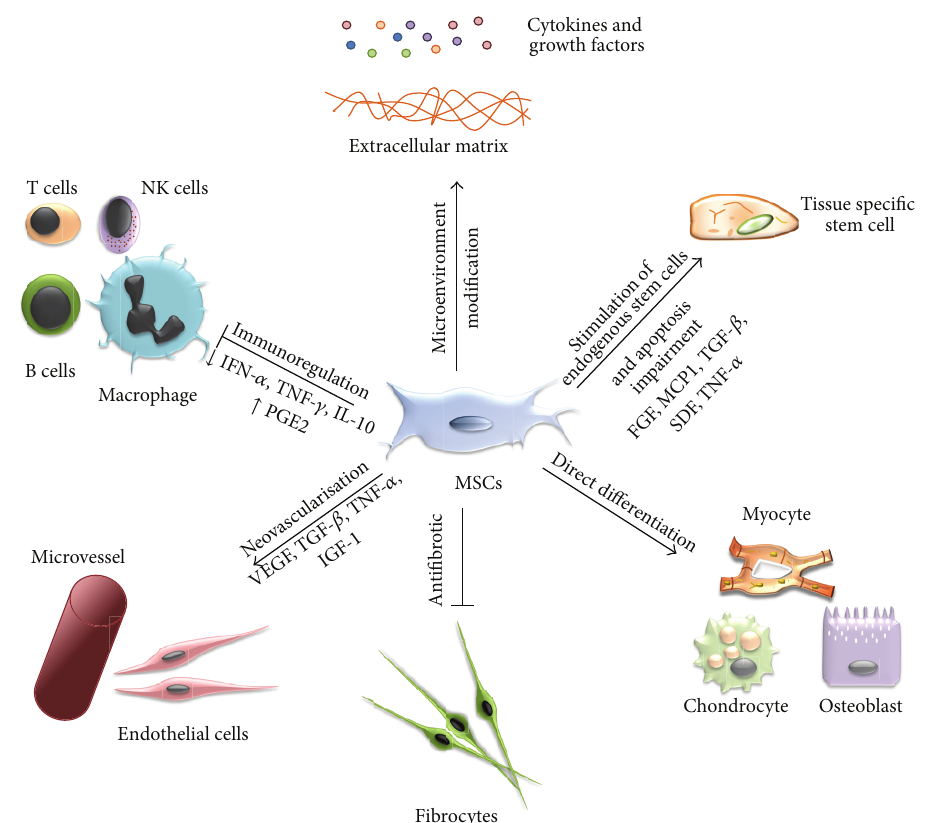
Figure 1: MSCs can enhance tissue regeneration via multiple